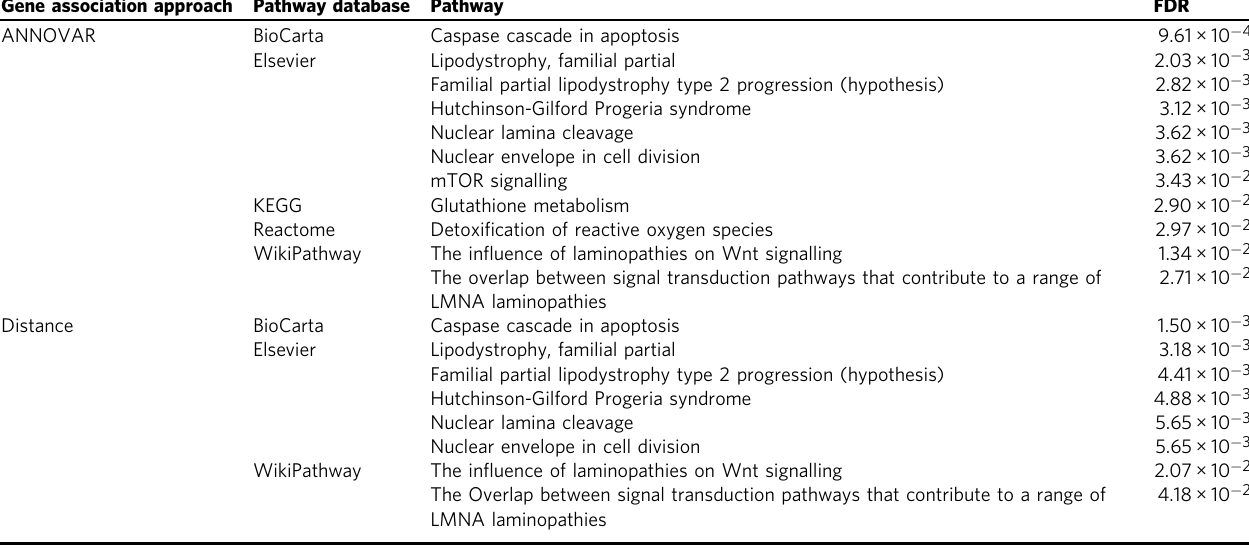
Table 2 Pathways of ANNOVAR- and distance-based differentially expressed genes associated with prostate cancer CpGs. Gene association approach Pathway database